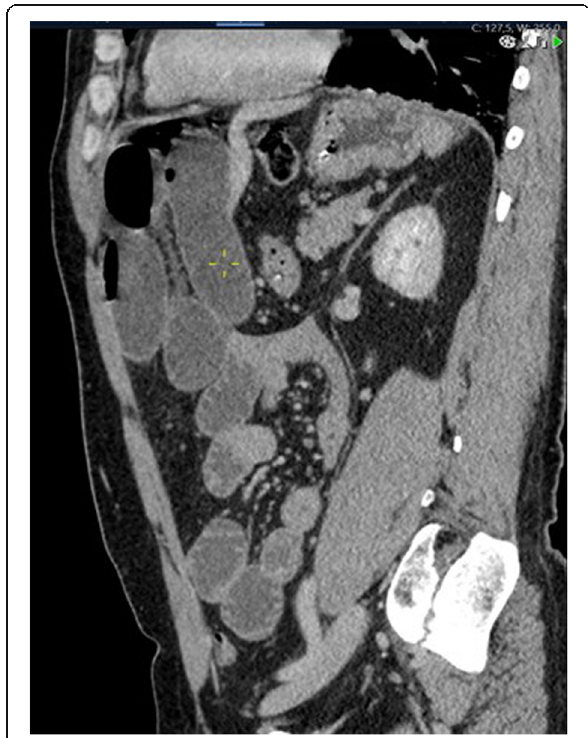
Fig. 4 Sagittal abdominal CT image showing dilated small bowel loops with mesenteric congestion and fat